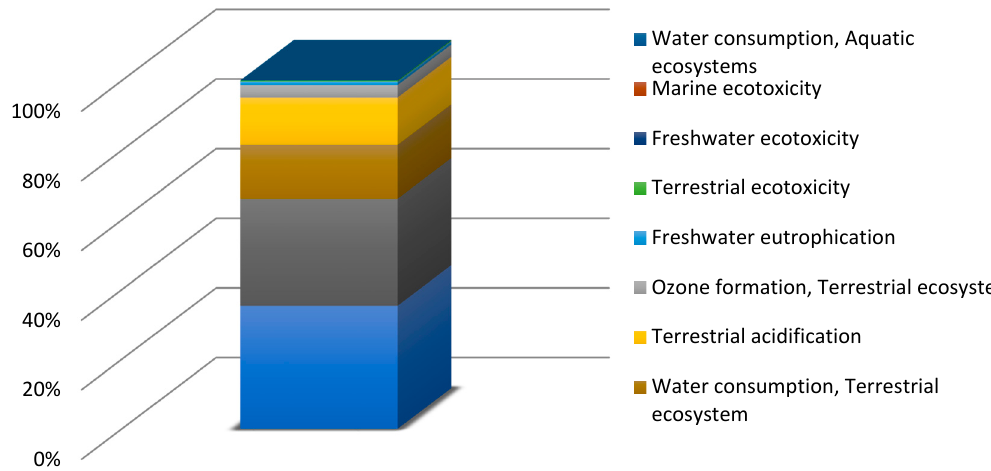
Figure 4. Contribution analysis in the human health damage category.